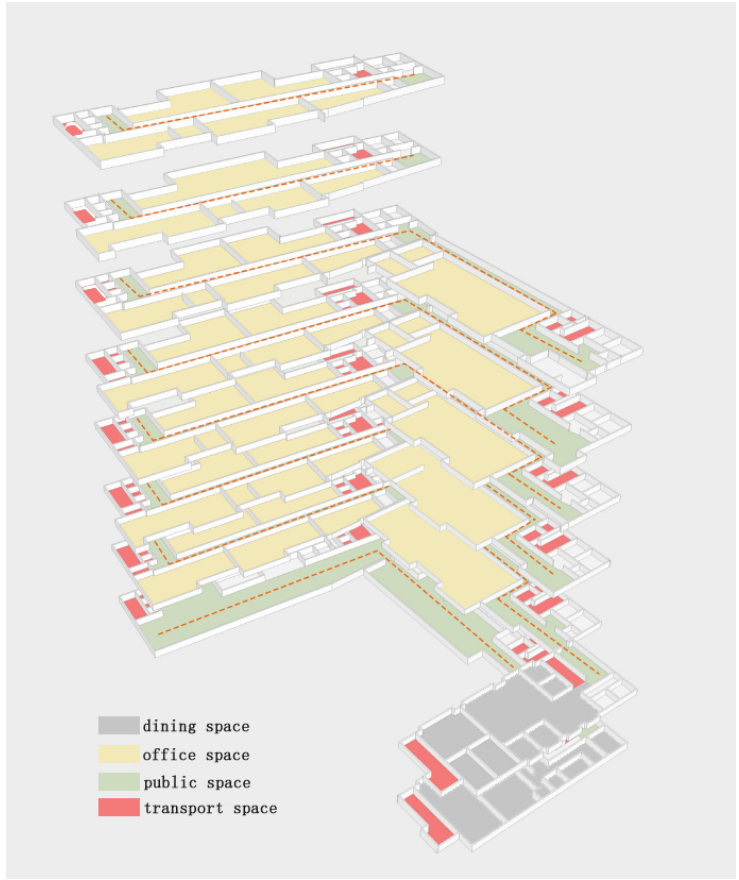
Fig. 2 Schematic diagram of building space.